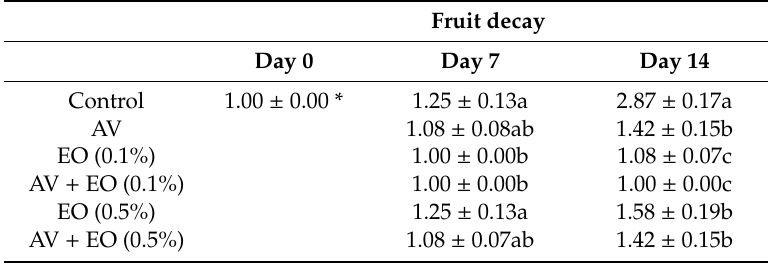
Table 2. E ff ect of Aloe vera (AV at 10%) coating and / or sage essential oil (EO at 0.1% and 0.5%) on tomato fruit decay during storage (11 ◦ C, 90% relative humidity (RH)). The degree of infection on fruit was rated using a scale of 1 to 5 (1—clean, no infection; 2—trace infection; 3—slight infection; 4—moderate infection and 5—severe